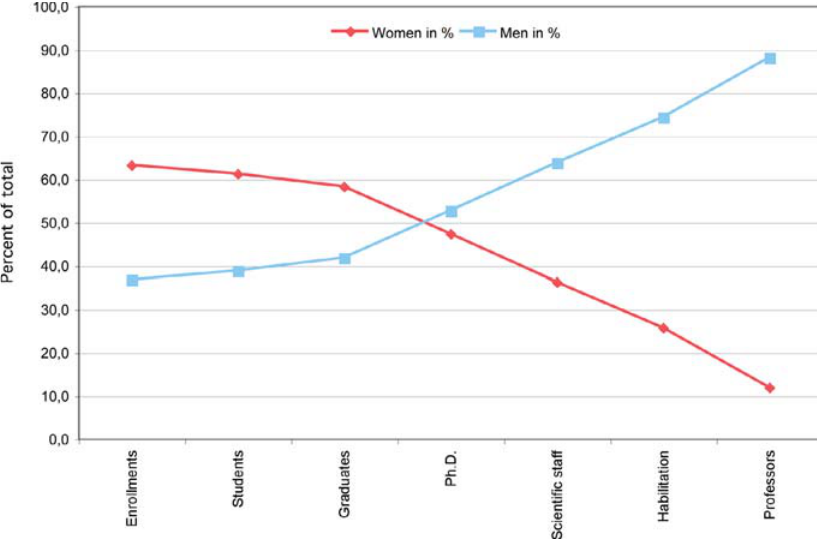
Figure 1. Scissors Diagram Showing the Gender Distribution within Career Stages in Biological Sciences at German Universities (2003) Percent male and female are shown for enrolling university students through graduation, PhDs awarded, scientifi c staff (includes post-doctoral fellows, some junior group leaders, and research scientists with university or PhD degrees), Habilitation (awarded for research accomplishments following the PhD as well as teaching experience, often a pre-requisite for university professorships in Germany), and professors (includes independent group leaders roughly equivalent to assistant, associate, and full professors in the American system—C2–C4 scale). Data prepared by Center of Excellence Women and Science (CEWS, http://www.cews.org/cews/ index.php). Source: Federal Statistical Offi ce